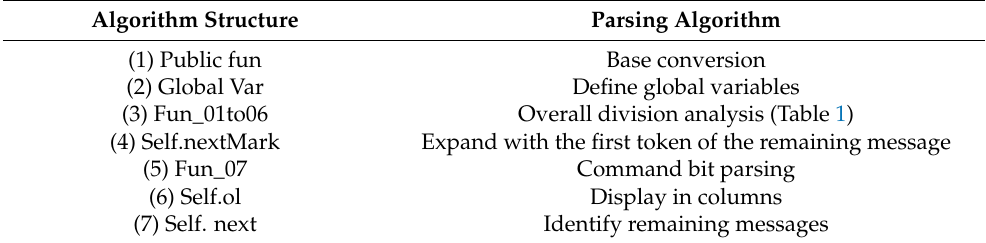
Table 4. Algorithm structure.